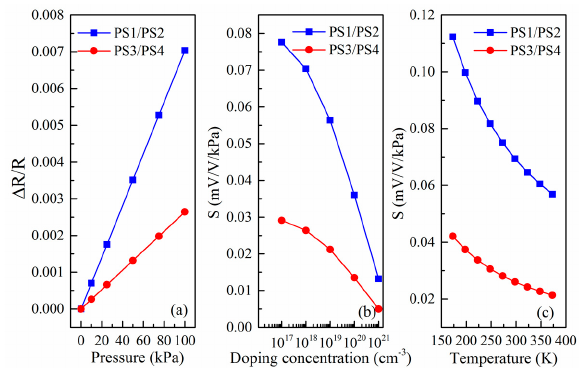
Figure 5. ( a ) Relative resistance change as a function of the applied pressure for array-type sensor; ( b ) variation of the sensitivity of array-type pressure sensor with the doping concentration; and ( c ) variation of the sensitivity of array-type pressure sensor with the temperature.